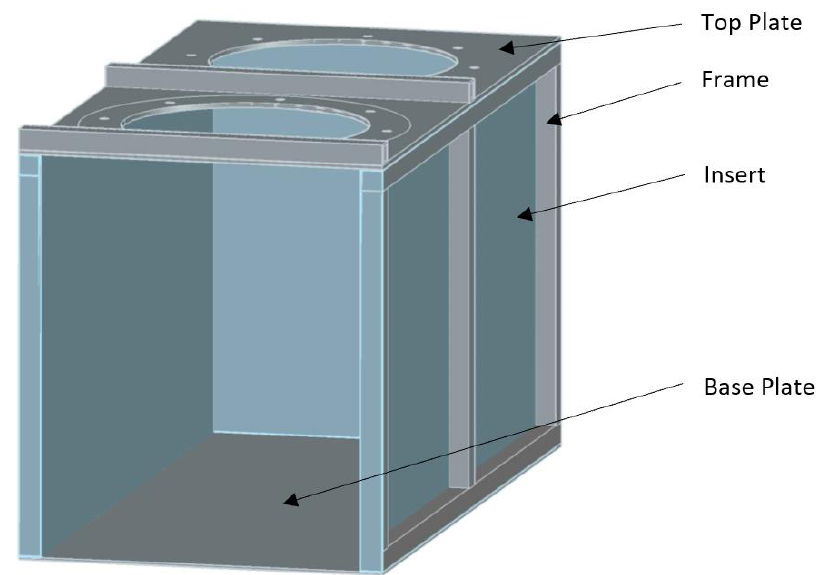
Figure 9. Case 3 box design, complete assembly, and actual construction.